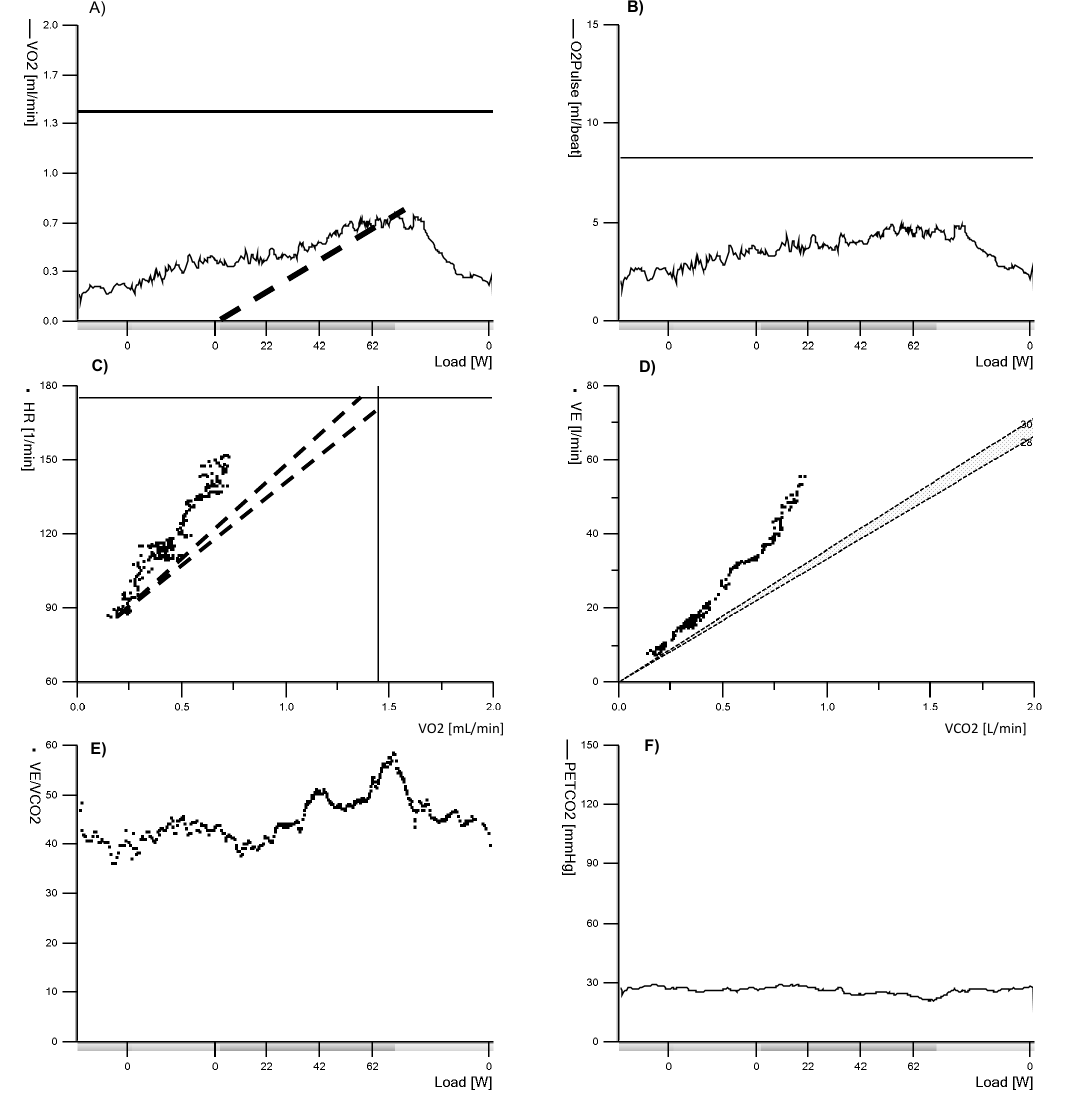
Figure 3. Typical CPET responses of a patient with PAH. The solid lines in ( A ), ( B ) and ( C ) indicate the predicted peak values of the respective variables. The dashed line in ( A ) represents a VO /WR slope of 10 mL.W./min − 1 – a healthy response would parallel this 2 line. Note the shallower VO /WR slope and reduced peak VO in PAH. Reduced peak 2 2 /VCO slope are evident in ( C ) oxygen pulse is seen in ( B ). Steep heart rate response and V E 2 and ( D ) respectively with the predicted response corridors indicated by dashed lines. ( E ) displays a markedly elevated ventilatory equivalent of CO while ( F ) shows 2